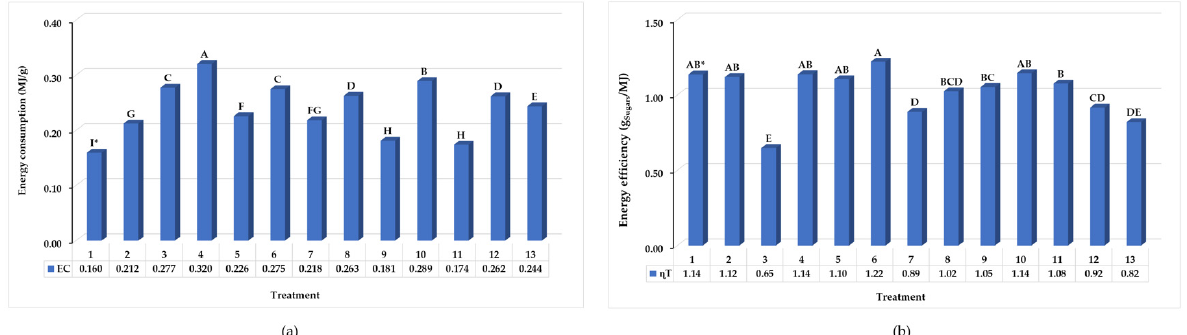
Figure 3. Energy balance in hydrothermal pretreatment. ( a ) Energy consumption (EC) per treatment; ( b ) energy efficiency ( ɳ T ) per treatment. * Different letters between bars indicate statistically significant differences ( p < 0.05).